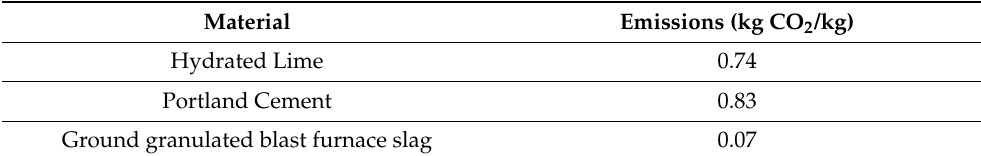
Table 5. Embodied emissions of Stabilisers.